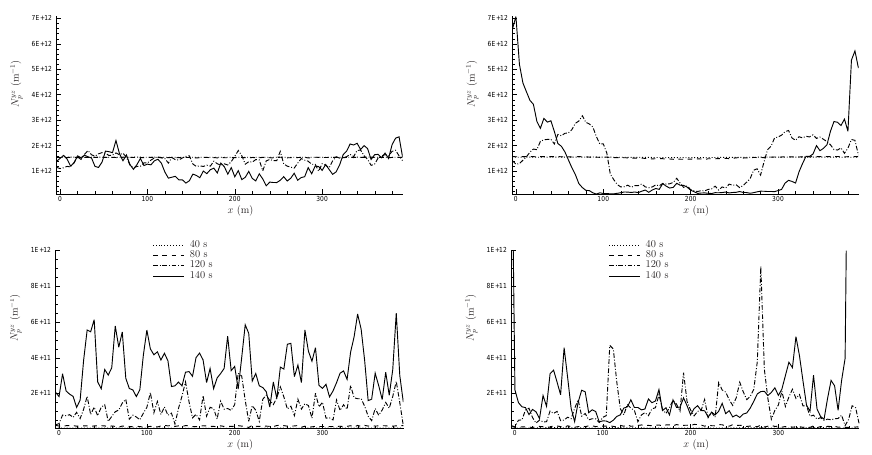
Fig. 11. Evolution of axial distributions of cross-stream integrated particle number density N yz p ( m − 1 ) in the primary wake (top panels) and secondary wake (bottom panels) for runs V 1 (left) and V 2